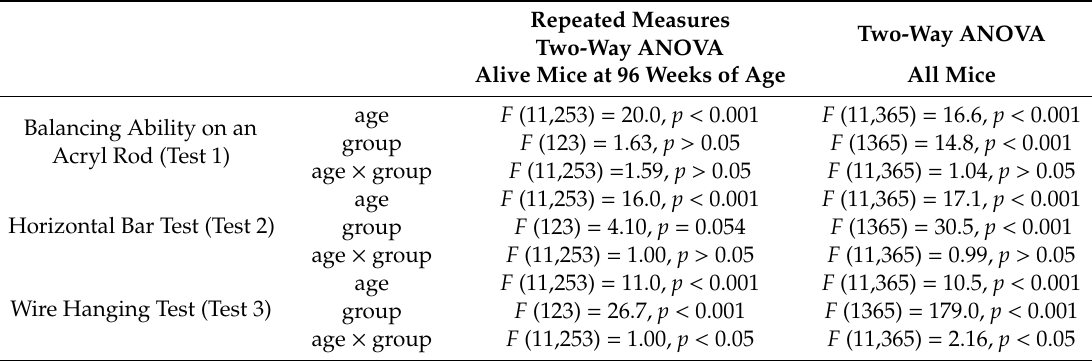
Table 1. Results of statistical analysis in Test 1–Test